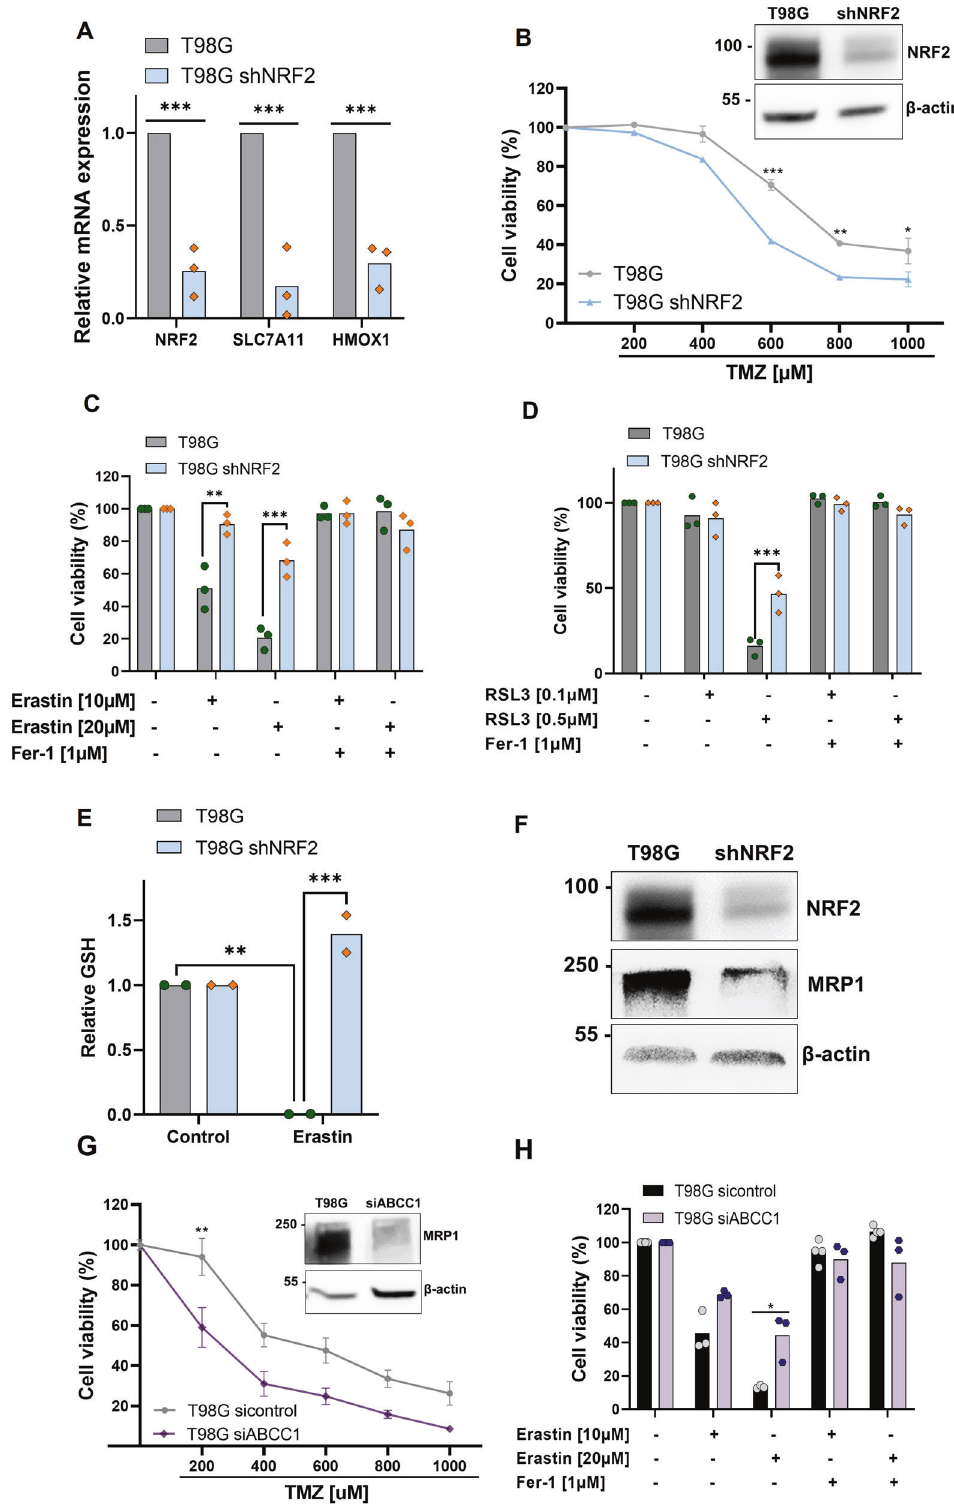
Kaplan-Meier curves with the CGGA, TCGA, and REMBRANDT datasets showed that glioma patients with higher levels of ABCC1 had a signi fi cantly shorter overall survival (OS) compared with patients with lower ABCC1 levels (Figs. 6E and S2E, S3E). In the CGGA cohort of patients, for instance, we observed a 5-year OS